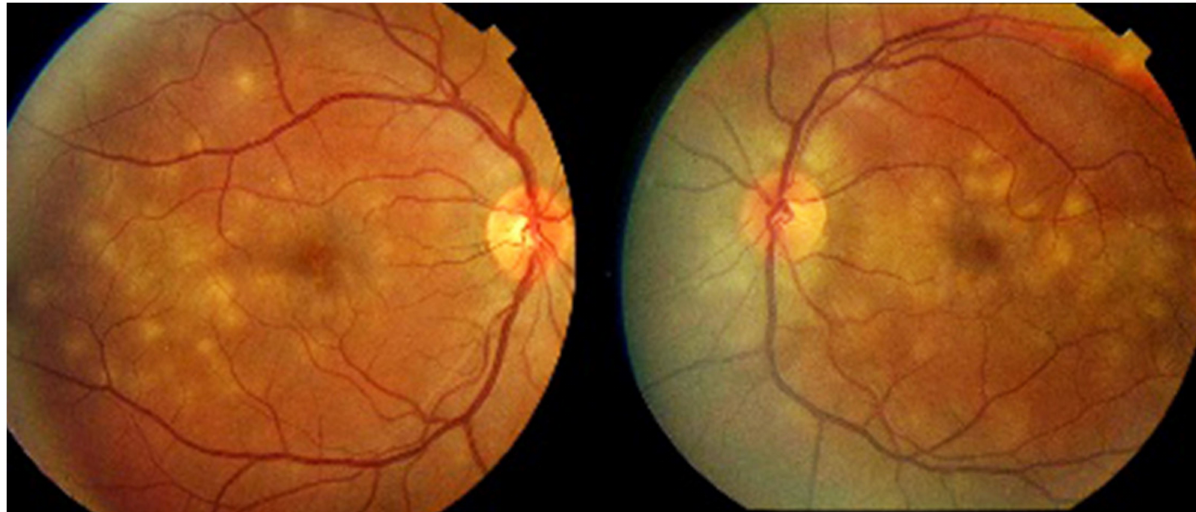
Figure 9. Numerous bilateral discolored plaques in a case of APMPPE/AMIC typical bilateral posterior disposition of placoid lesions.